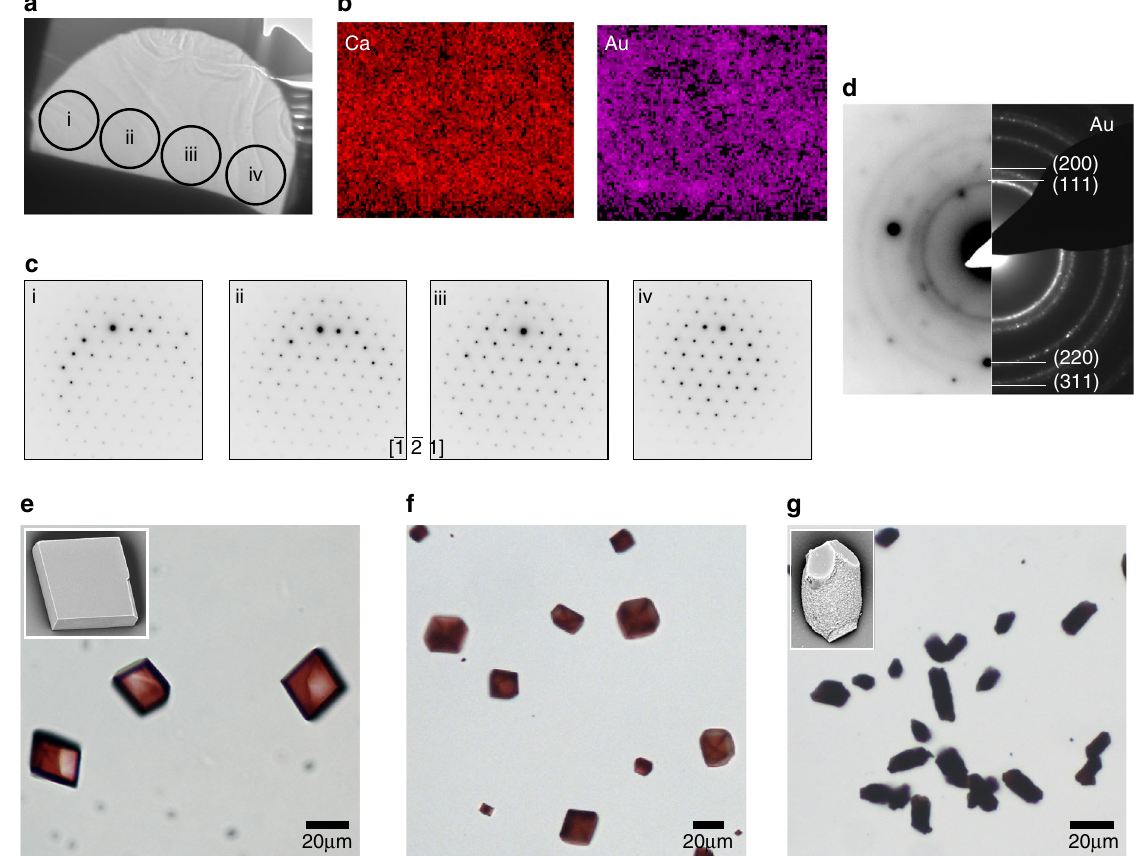
Fig. 7 TEM and optical micrographs of calcite crystals precipitated in the presence of 4 nm PGMA-NPs. a Low-magni fi cation bright fi eld TEM image of an FIB-cross-sectioned calcite lamella showing the areas from which the selected area electron diffraction patterns (SAED) were taken. b STEM HAADF EDX mapping showing the homogeneous distribution of Ca and Au. c Corresponding SAED patterns demonstrate that single crystallinity is maintained throughout the crystal shown in a . d Off-zone axis SAED pattern showing rings corresponding to gold, which matches with diffraction pattern of Au NPs alone. e – g Optical micrographs of calcite crystals grown at concentrations e 0.001 wt%, f 0.005 wt%, and g 0.02 wt% 4 nm